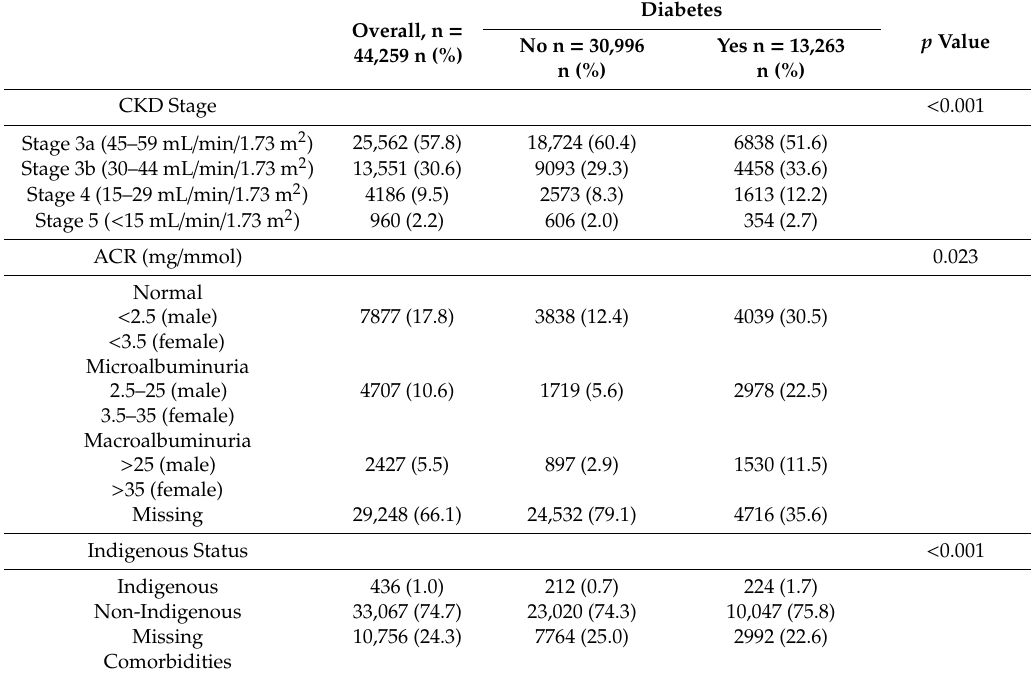
Table 2. Comorbidities of patients with CKD overall and by diabetes